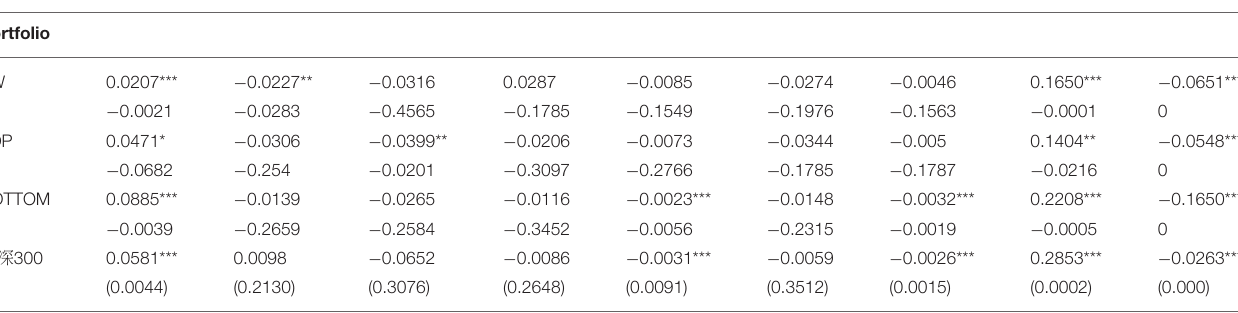
TABLE 6 | Linear regression results based on all